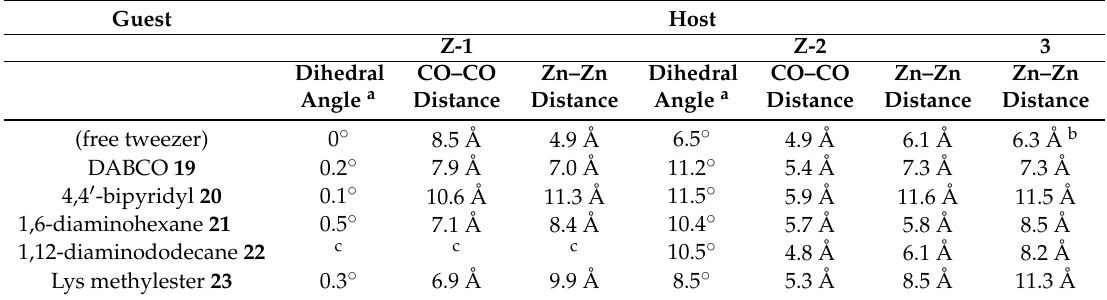
Table 2. Dihedral angles, spacer C=O–C=O distances, and Zn – Zn distances (Å) from conformational analysis of tweezers 1 – 3 with bound guests.